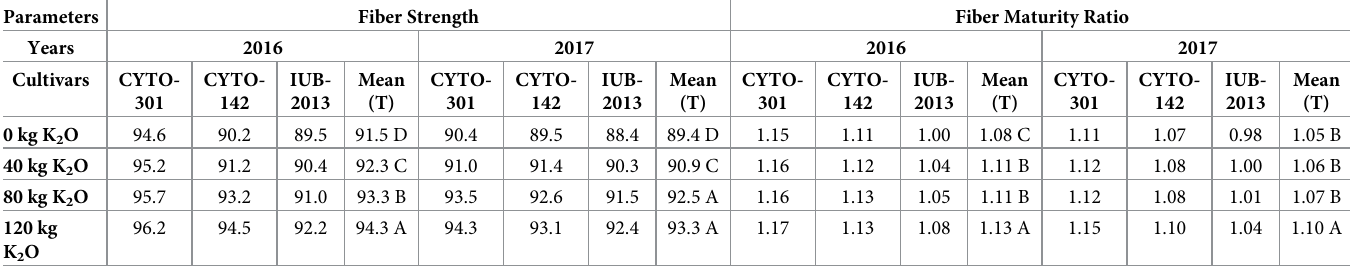
Table 7. Impact of different levels of soil applied K 2 O on fiber strength and fiber maturity ratio of cotton cultivars grown under K deficient soil. Parameters Fiber